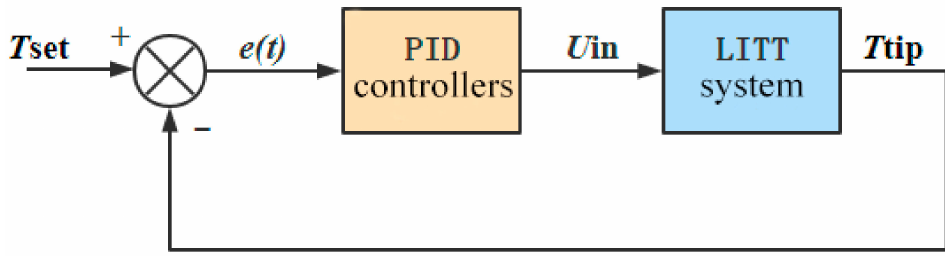
Figure 2. PID control principle.